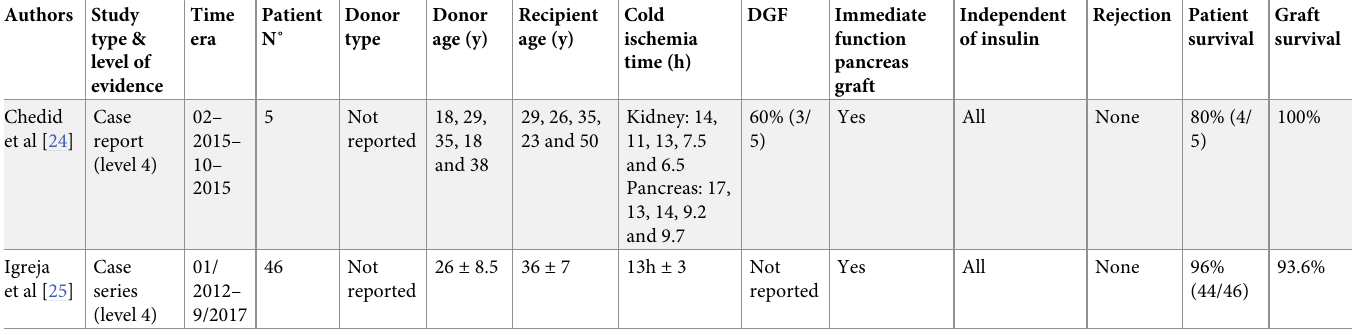
Table 4. Overview of outcome measures for the case series reporting on simultaneous pancreas and kidney